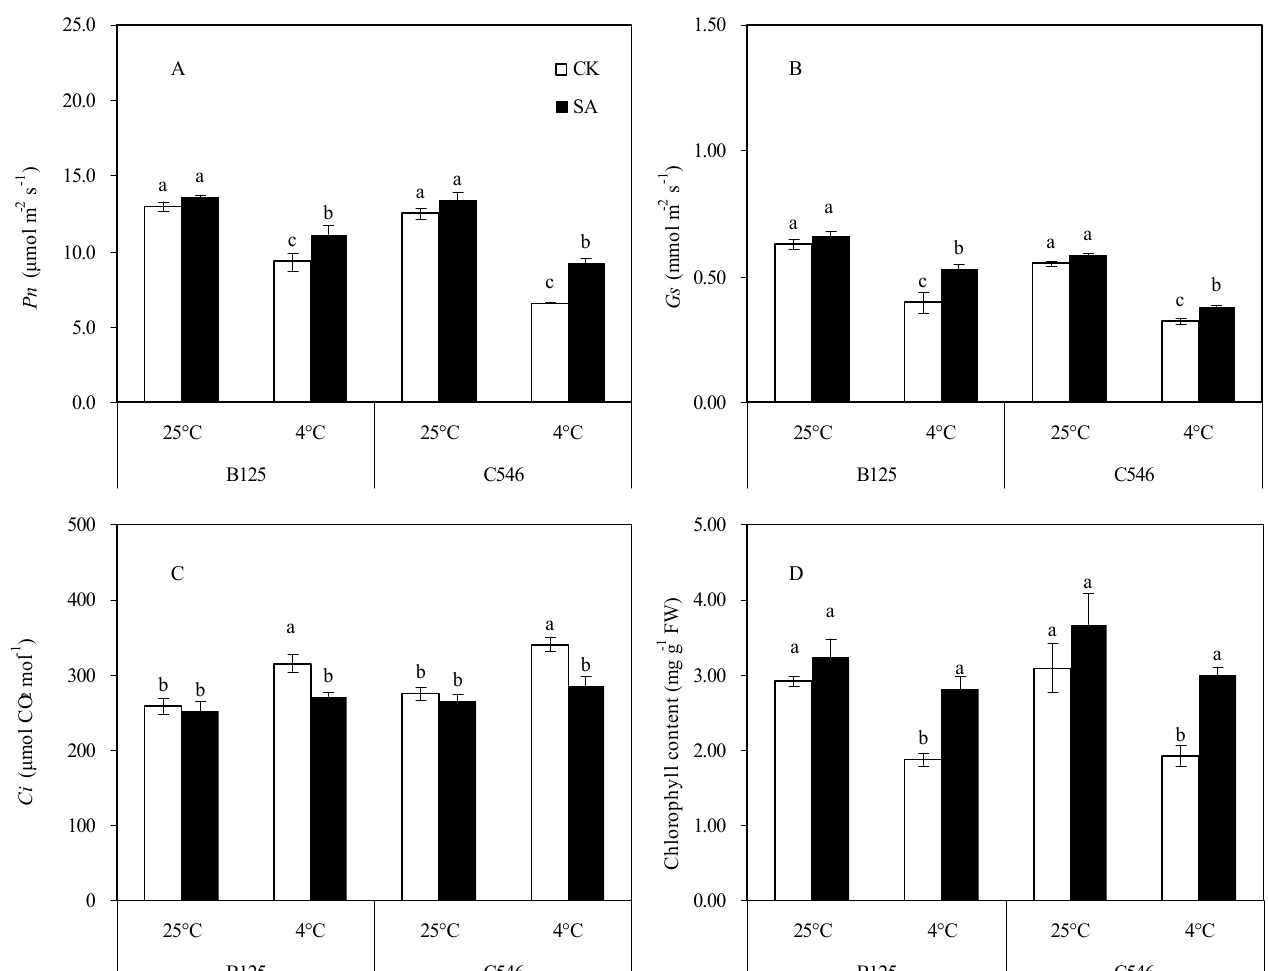
Figure 3. Effects of SA treatment on photosynthesis in C546 and B125 maize seedlings. ( A ) Pn , ( B ) Gs , ( C ) Ci , and ( D ) chlorophyll content. The plants were treated at 4 °C for 2 days. The different letters indicate significant differences between different SA concentrations under two temperatures within the same inbred line at p < 0.05.